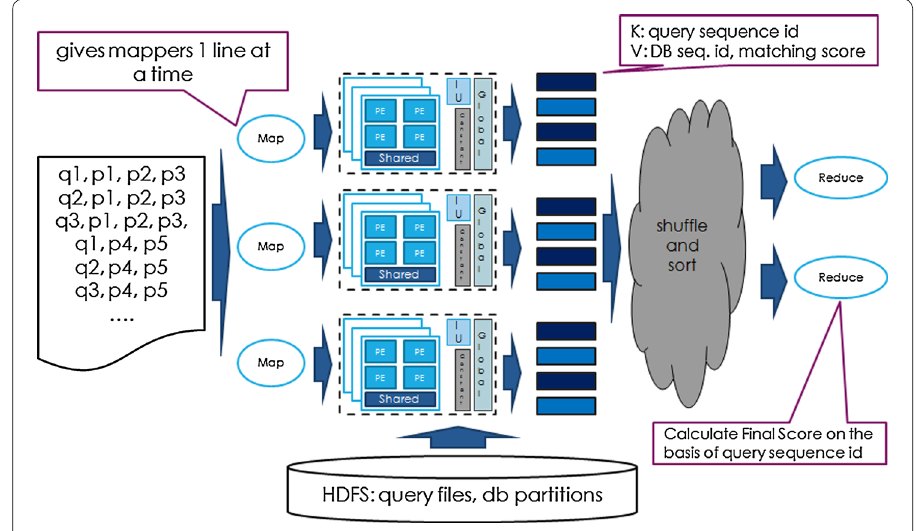
Fig. 1 Algorithm for